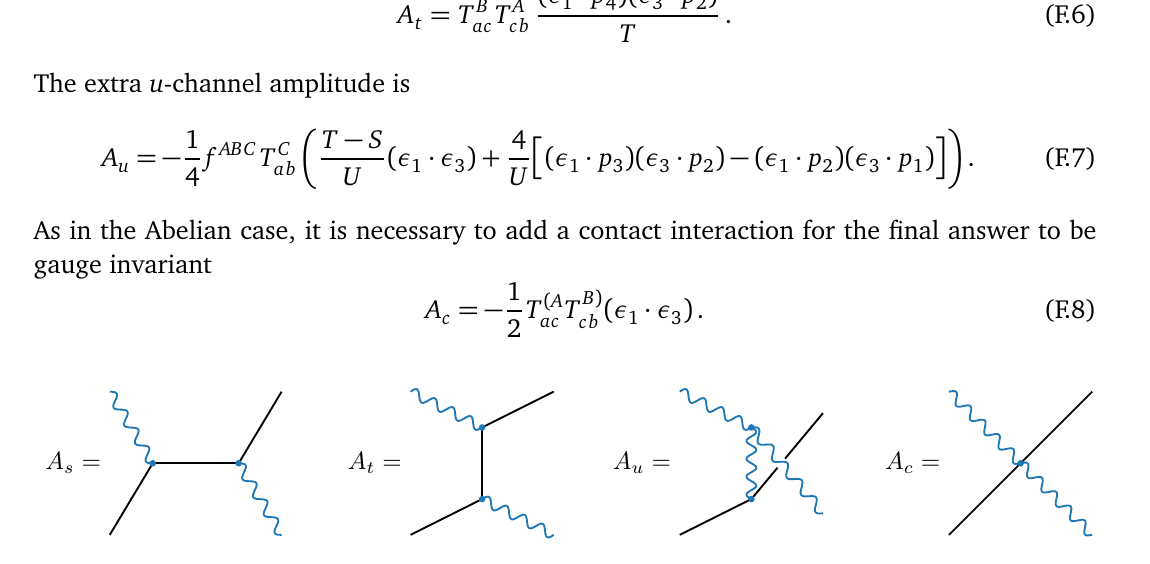
Figure 14: Feynman diagrams of the different tree-level contributions to Compton